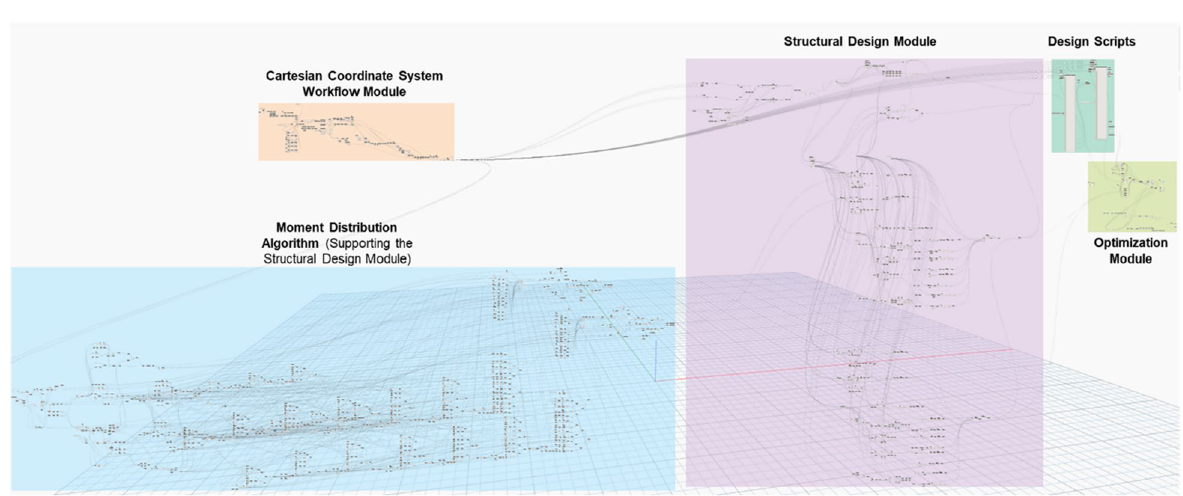
Figure 2. Overall model screenshot from the dynamo